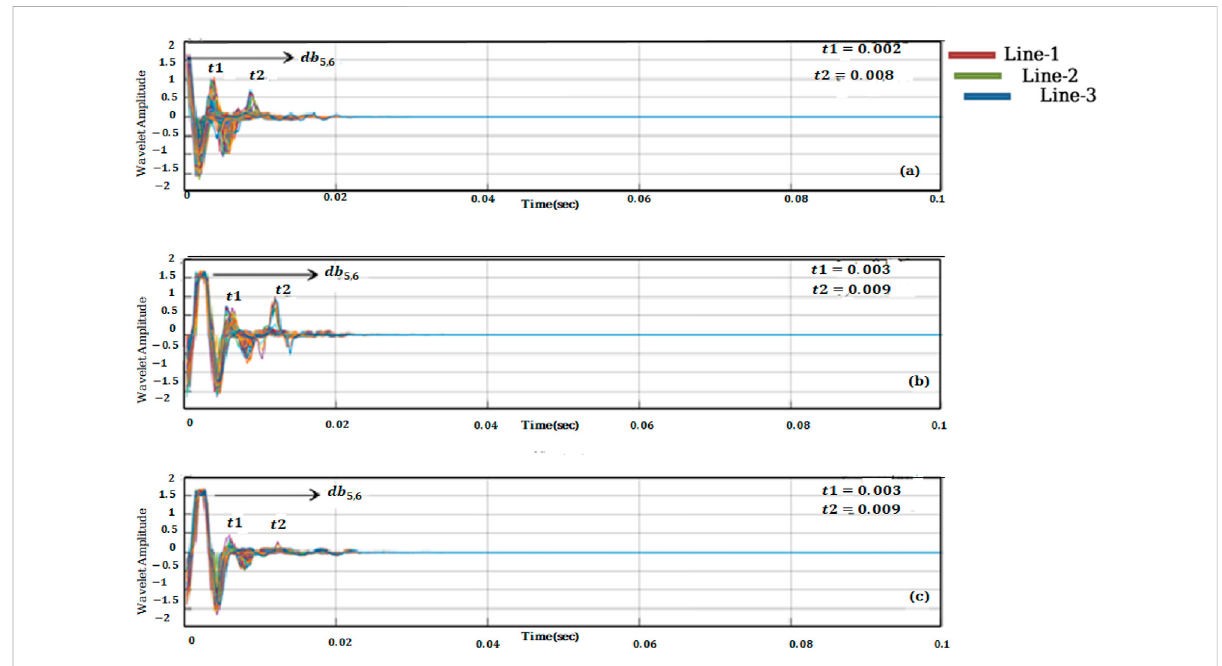
FIGURE 11 Modules curvesof wavelet transform coef fi cients obtained by using wavelet transform for typical single-channel signal on survey lines 1, 2, and three are shown as (A – C) at various stretch scales: (A) = 1.9; (B) = 3.9; (C) =